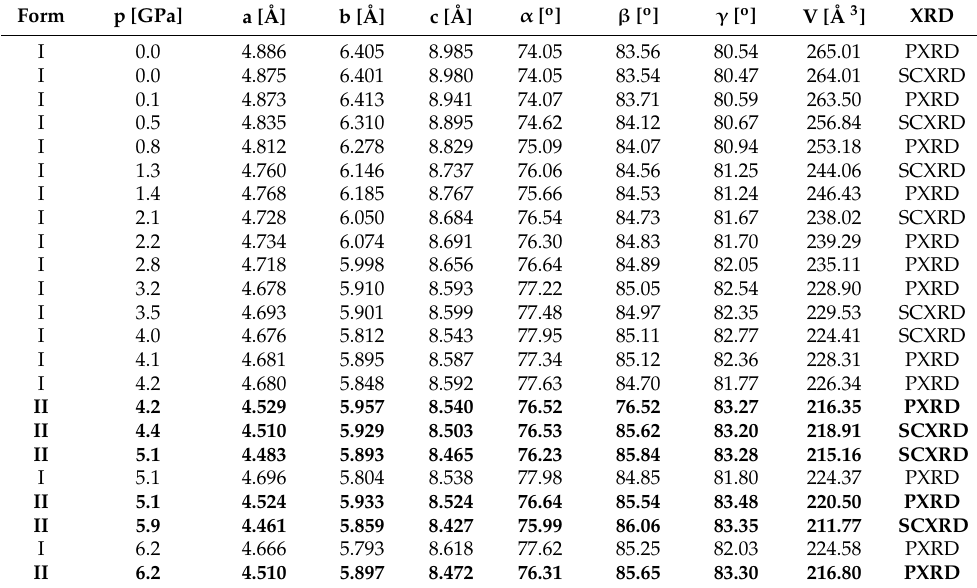
Table 1. Structural parameters of crystal forms of chlorothiazide. Data for Form II were bolded to increase the